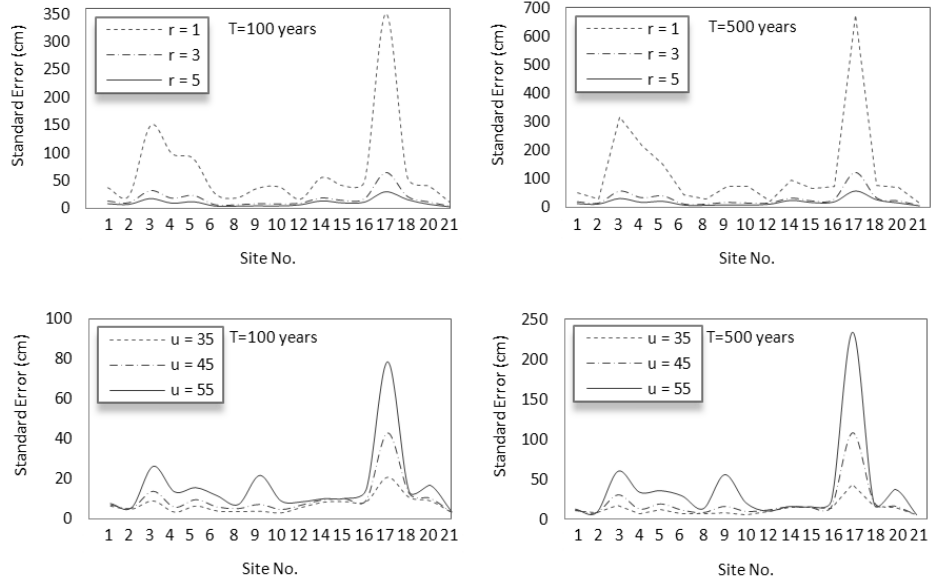
Figure 4. The standard error associated with 100-year (left) and 500-year (right) surges versus the value of r (the r -largest observations) and u (threshold). T is the return